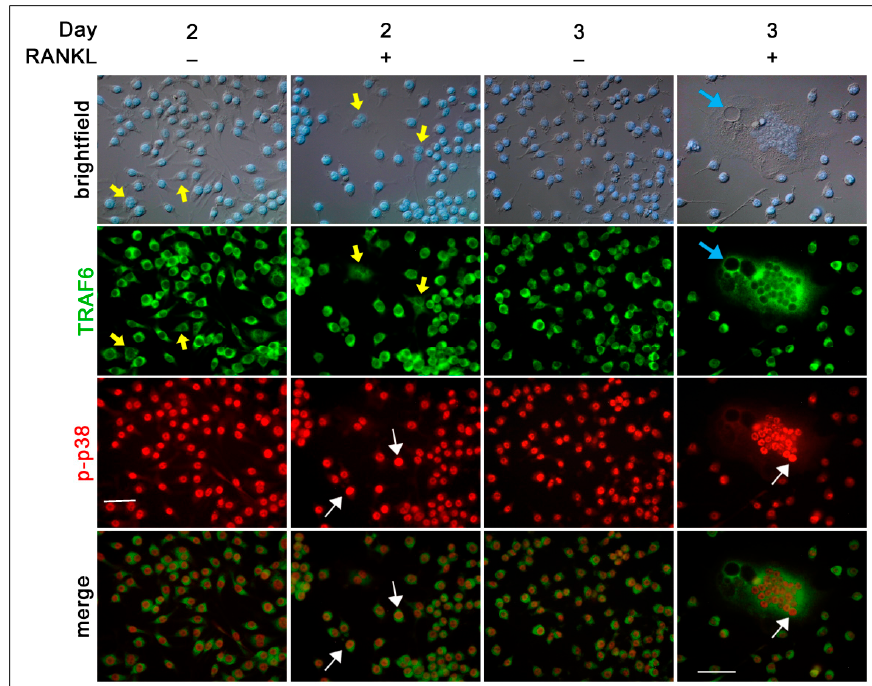
Figure 6. TRAF6 and p-p38 subcellular co-localization. Cells were cultured in the absence (RANKL − ) or in the presence of RANKL (RANKL + ) for 2 and 3 days. Cells were stained with anti-TRAF6 (green) and p-p38 (red) antibodies. Yellow arrows, low TRAF6 staining intensity. White arrows, high p-p38 staining intensity. Turquoise arrow, vacuoles in multinucleated cells. The data shown represent two independent experiments with comparable outcomes. Magnification 40×. Scale bar of 50 µm.